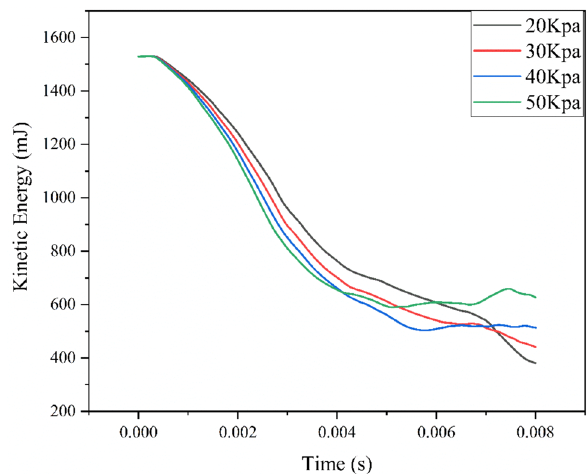
Fig. 12 Energy Saving Lamp kinetic energy-time change curve